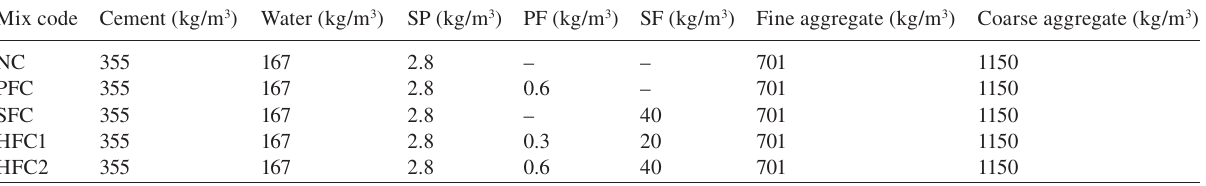
Table 4 Mix proportions of concrete series.